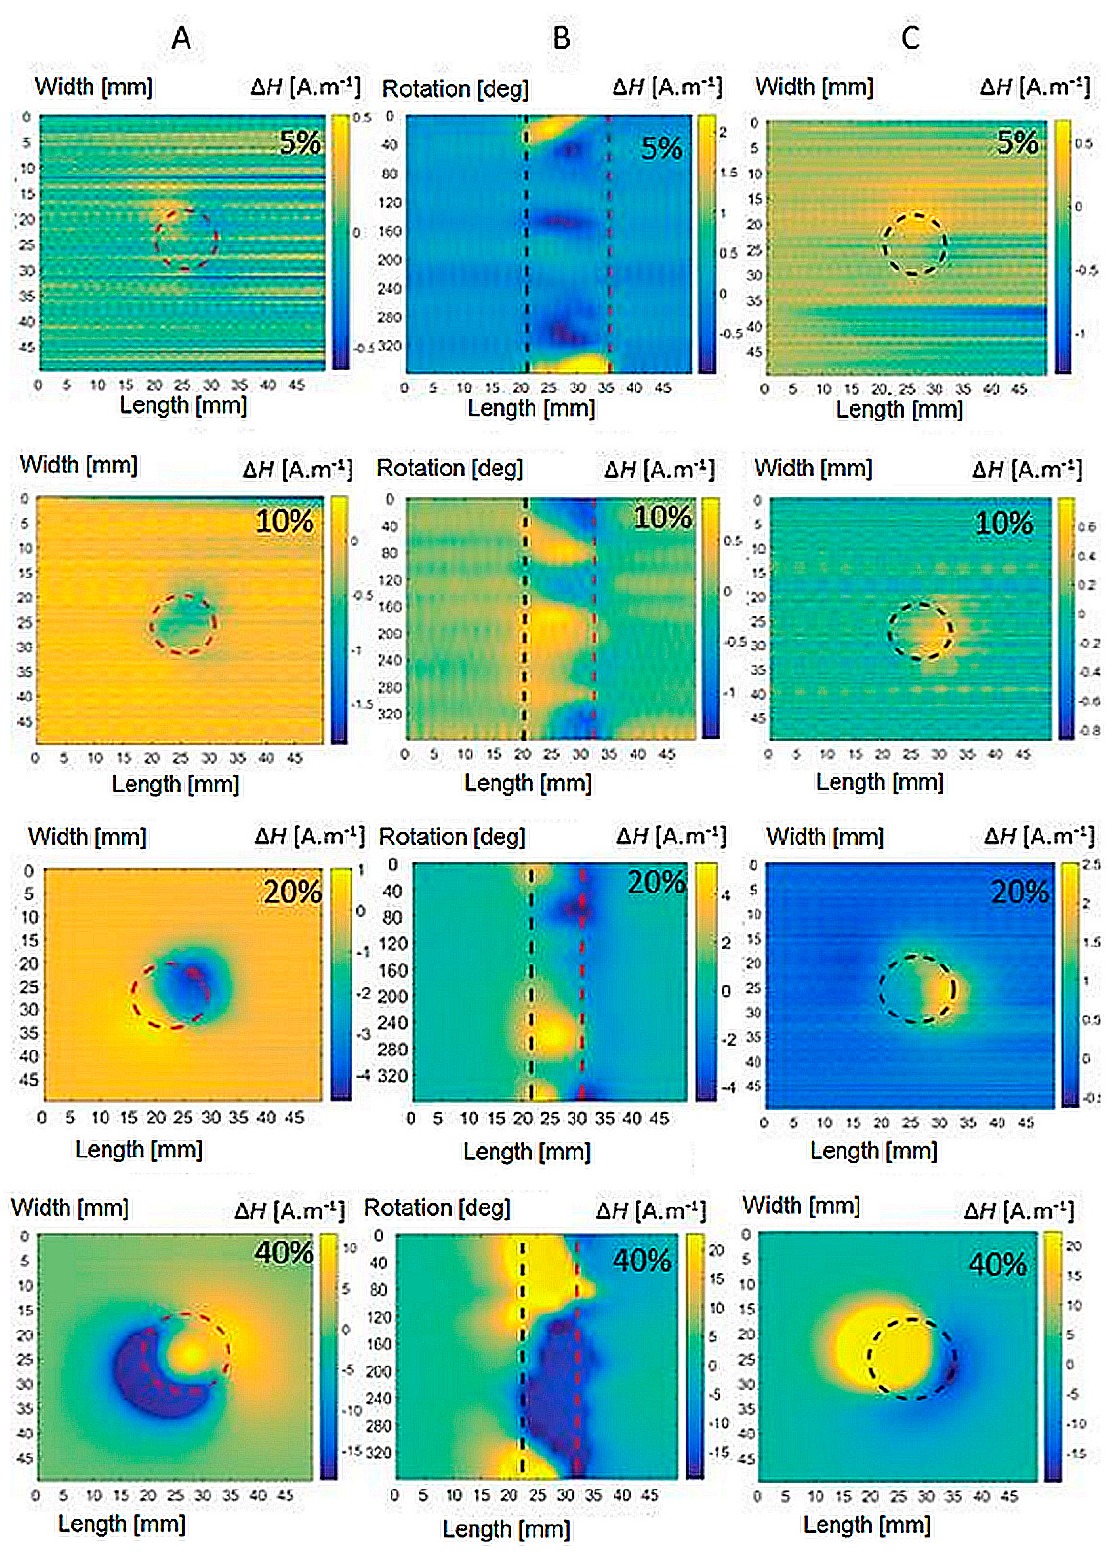
Figure 12. Magnetic field distribution of bases ( A , C ) and shell ( B ) of AISI 316Ti specimens of all plastic deformations.